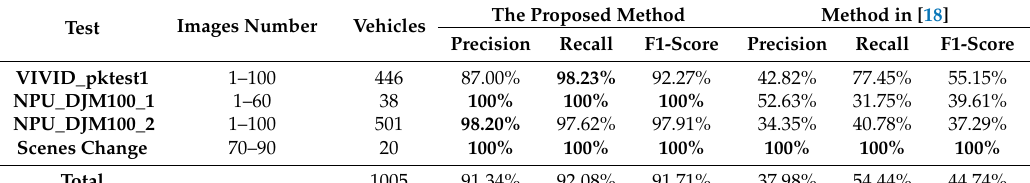
Table 5. Comparison with the state-of-the art method, the bold value of each row is the best performance.